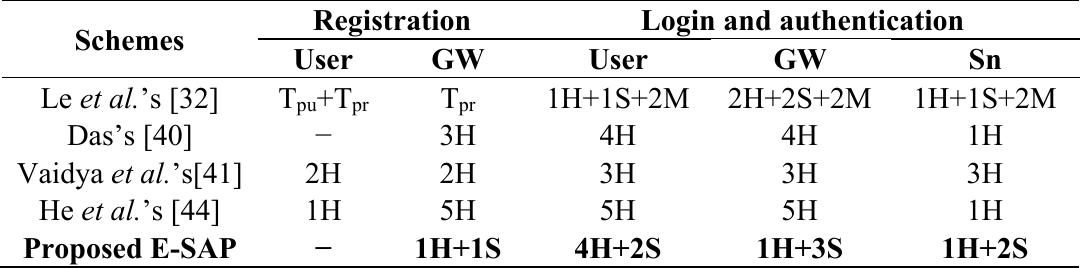
Table 5. Performance comparison of E-SAP with existing